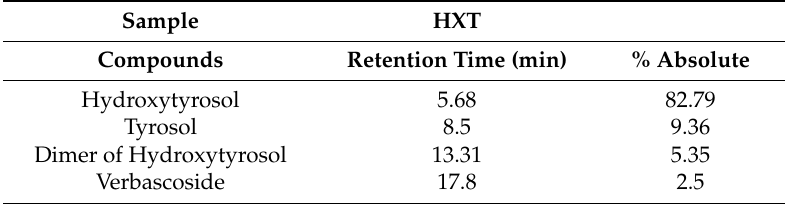
Hydroxytyrosol (HXT) extract composition measured by high performance liquid chromatograph